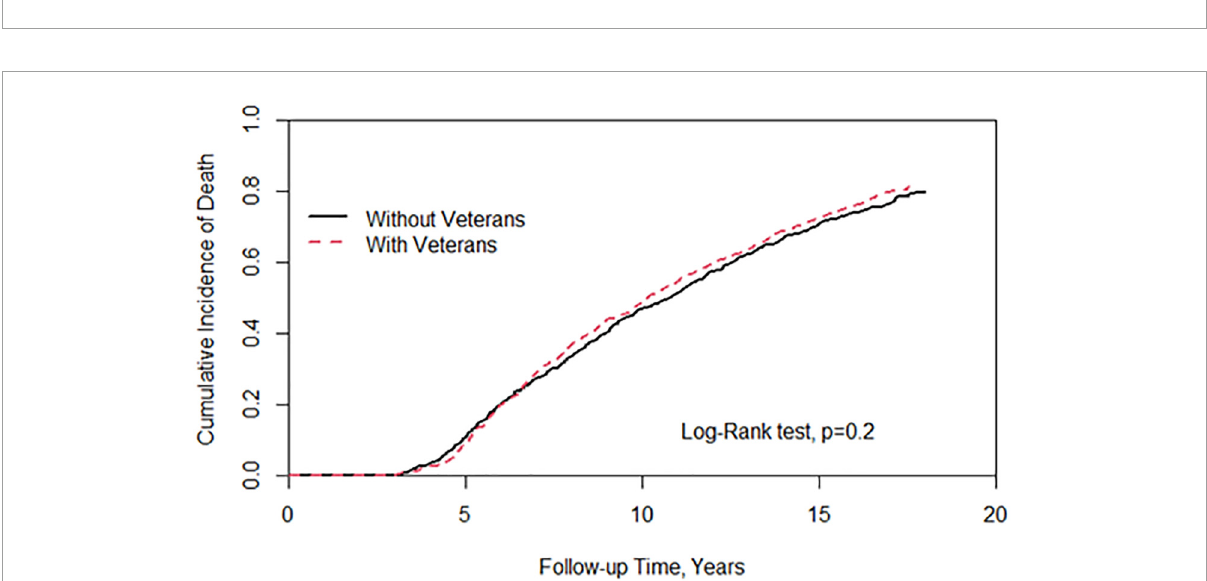
FIGURE2 Cumulative incidence of all-cause mortality between individuals with and without veterans